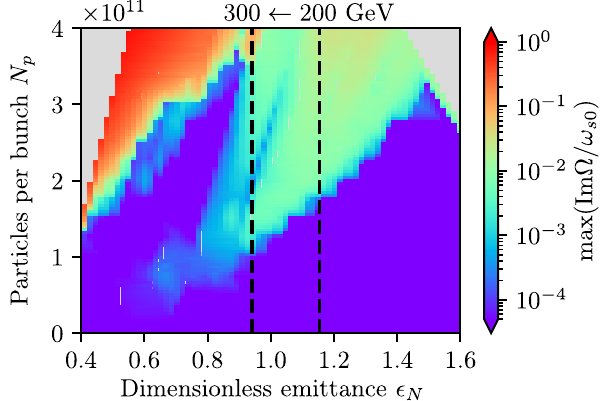
FIG. 16. Stability map applicable to various points of the acceleration (200 – 300 GeV) obtained with melody for ϕ ¼ 2 . 56 . Background color describes the instability growth s 0 rates. Two vertical dashed lines indicate the range of the dimensionless emittances for the total longitudinal emittance ϵ ¼ 0 . 33